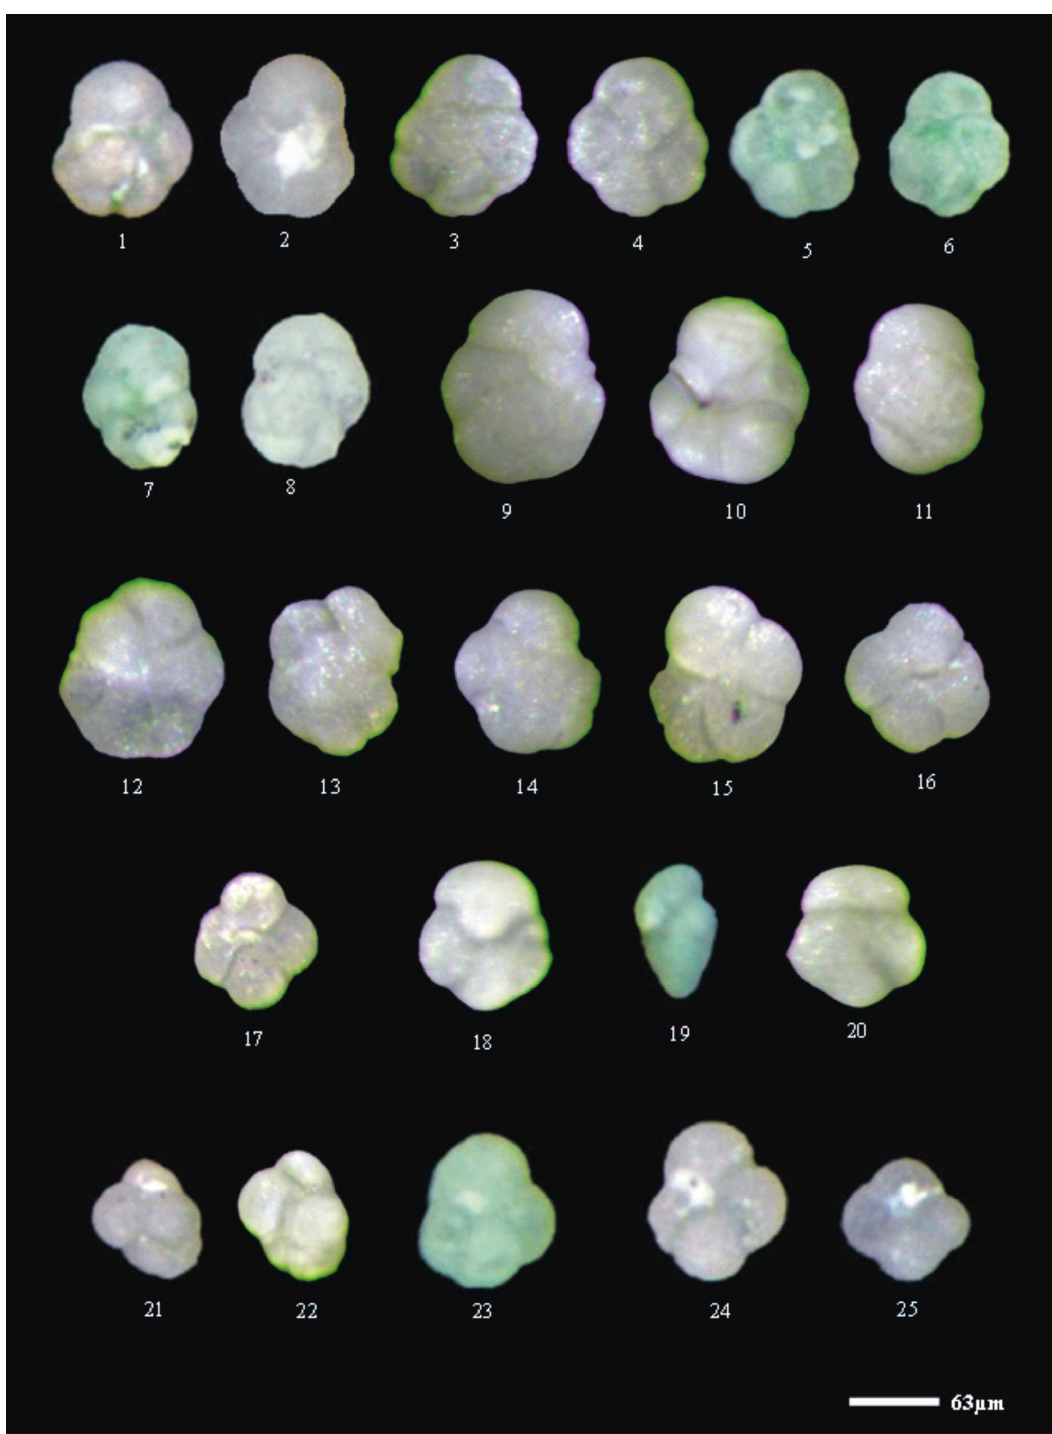
Figure 5. Planktonic foraminifera identified in the gypsum sample (digital photos): (1,2). Paragloborotalia sp. 2; (7,8). Paragloborotalia sp . 3 ; Globorotalia bykovae Aisenstat; (9–12). Globorotalia transylvanica Popescu; (13). Globorotalia sp. 3; (14,15). Globorotalia transylvanica Popescu; (16). Tenuitella angustiumbilicata (Bolii); (17). Globigerina sp.; (18–20). Globorotalia praescitula Blow; (21,22). Globigerinita uvula (Ehrenberg); (23). Globoturborotalita aff. woodi (Jenkins); (24). Globigerina praebulloides Blow; (25). Globigerina bollii Cita & Premoli-Silva.